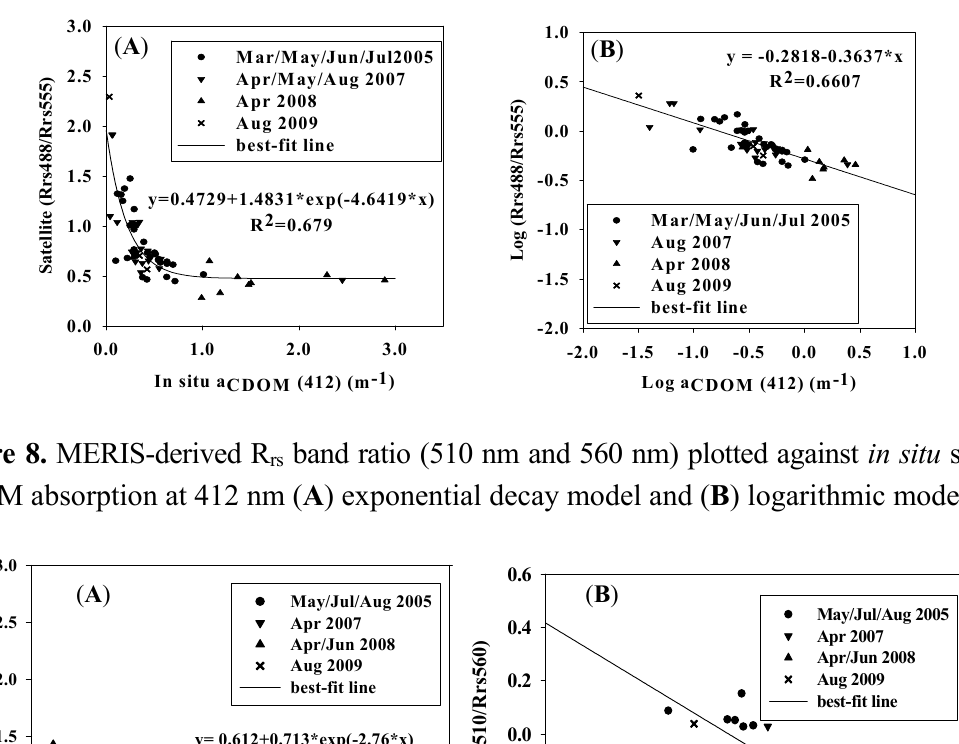
y= 0.612+0.713*exp(-2.76*x) R2